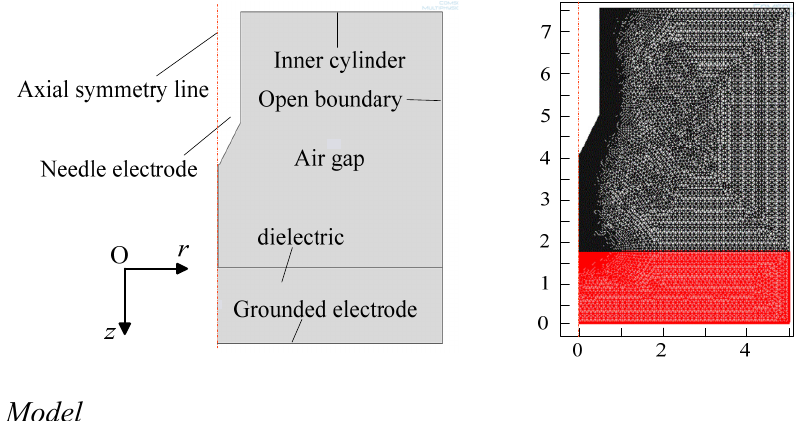
Figure 4. The geometry model including a half needle (units in